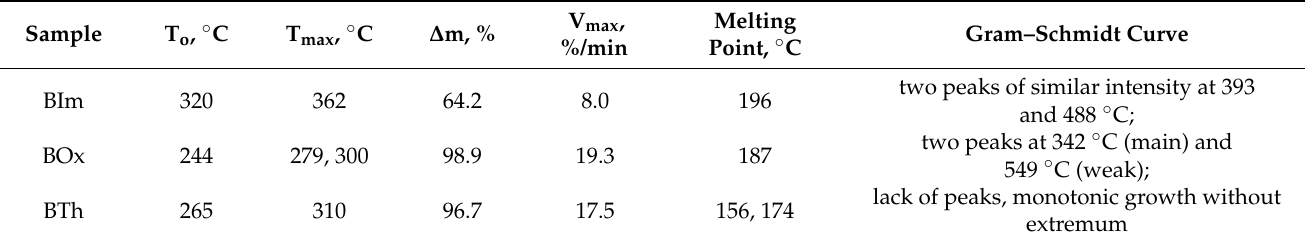
Figure 2. TG ( a ), DTG ( b ), DSC, and Gram – Schmidt graphs ( c ) of BIm, Box, and BTh compounds. Table 1. Parameters of heterocyclic compounds (BIm, BOx, and BTh) determined from TG, DTG, DSC, and Gram–Schmidt